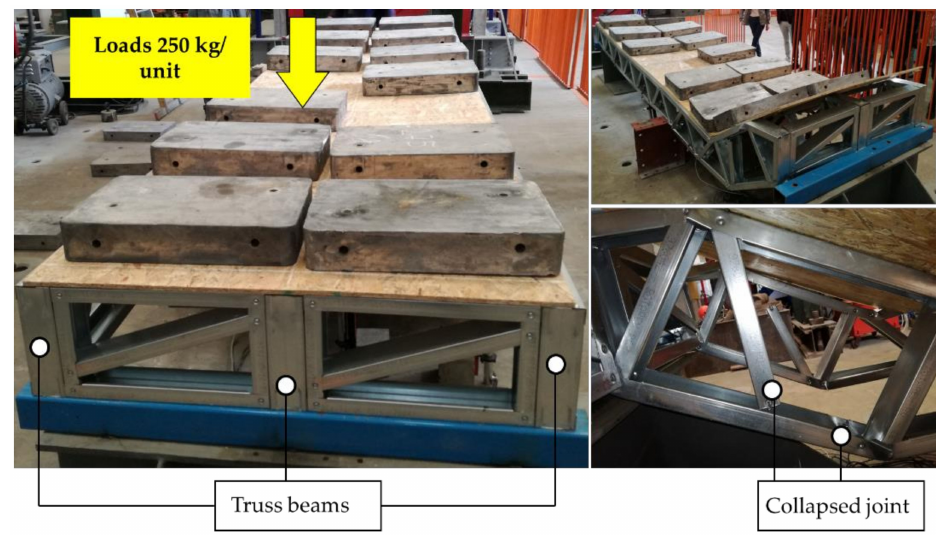
Figure 4. The floor truss system after the experimental test with the detail of the failure